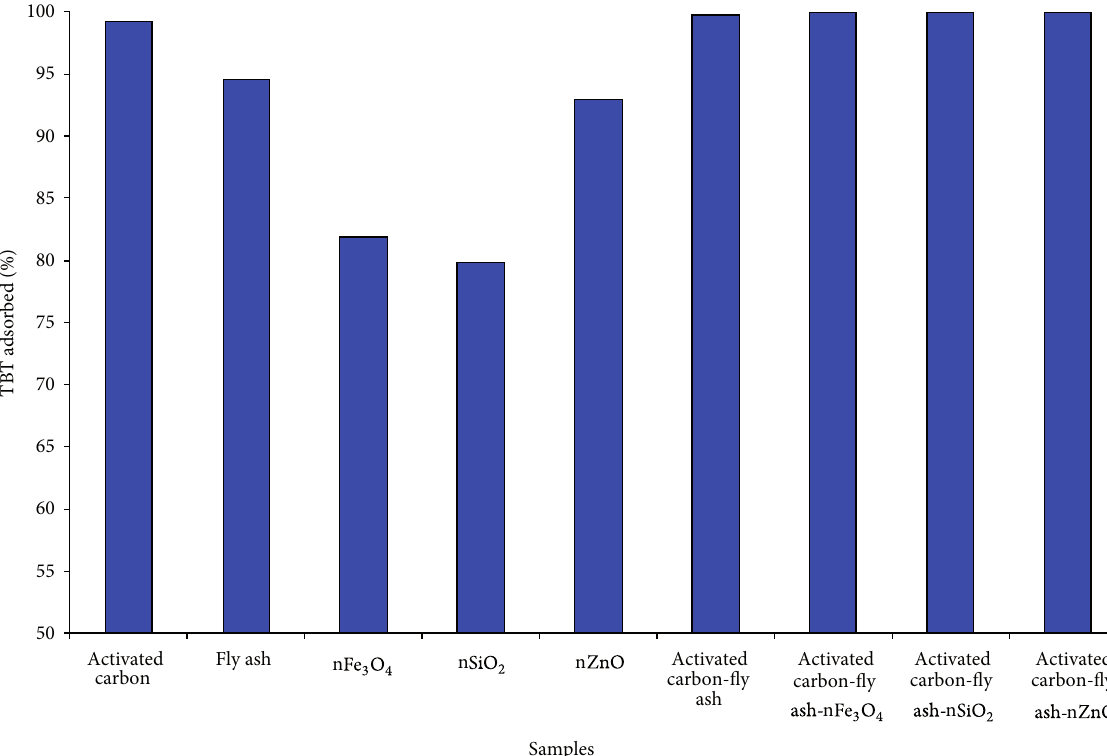
F 27: Removal efficiency of TBT by the precursors and composite materials. Experimental conditions: concentration of TBT =